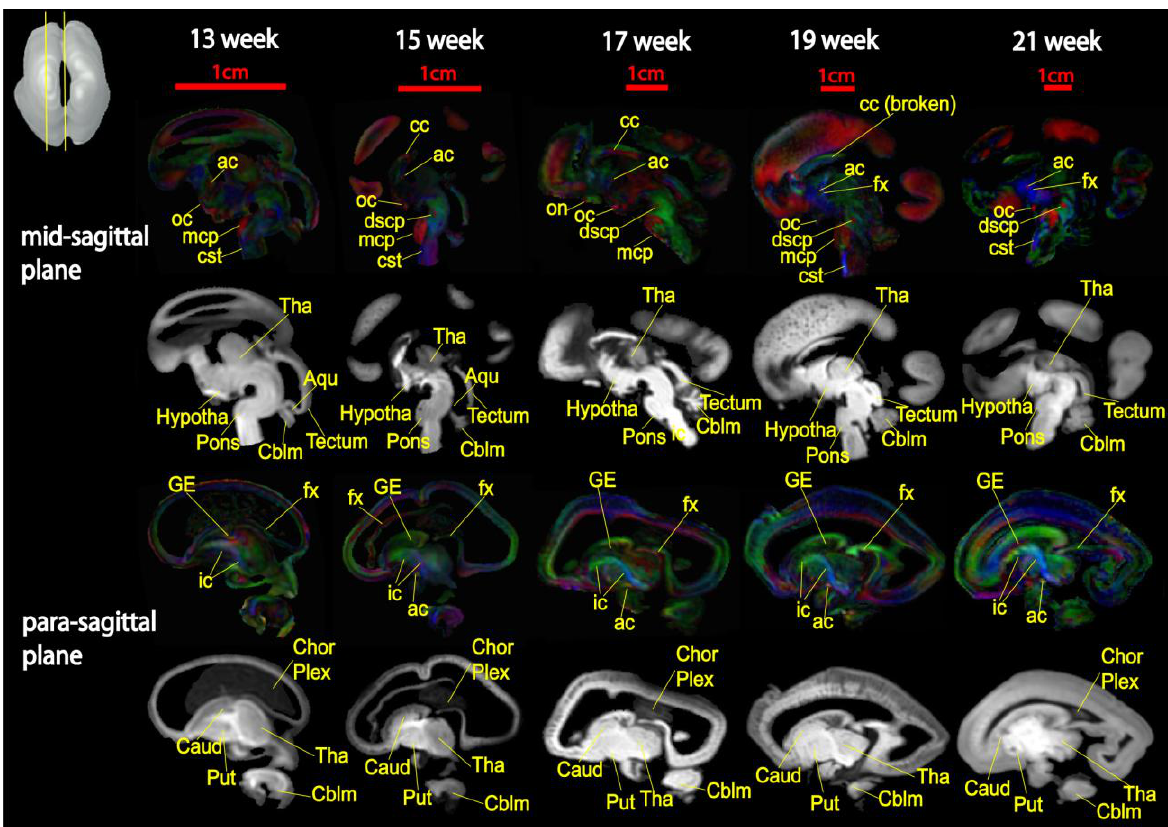
FIGURE 2. Fetal brain DTI atlas in sagittal planes. The location of each plane is demonstrated as yellow lines cross-sectioning the brain at the upper-left corner of each panel. Scale bars are shown at the top of the figure. Annotations of major white matter tracts and GE are shown in the directionally encoded color maps (the first and third rows) of fetal brains with 13, 15, 17, 19, and 21 weeks of gestational age. Annotations of other major neural structures are shown in the correspondent aDWI images in the second and fourth rows. Abbreviations not shown in text are as follows: cc, corpus callosum; cst, cortical spinal tract; dscp, decussation of superior cerebellar peduncle; mcp, middle cerebellar peduncle; oc, optical chiasm; on, optical nerve; Aqu, aquarium; Cblm, cerebellum; Chor Plex, choroid plexus; Hypotha, hypothalamus; Tha,